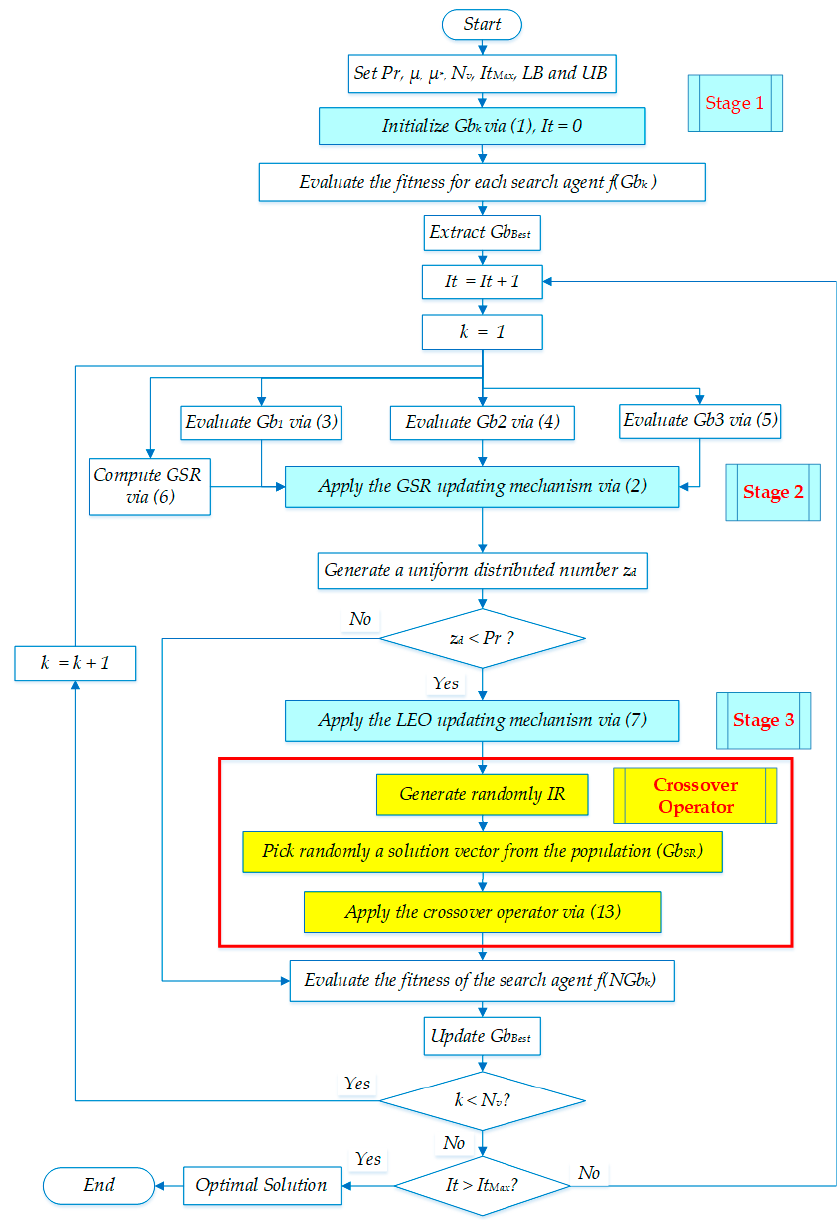
Figure 1. Main stages of the employed GBOC.